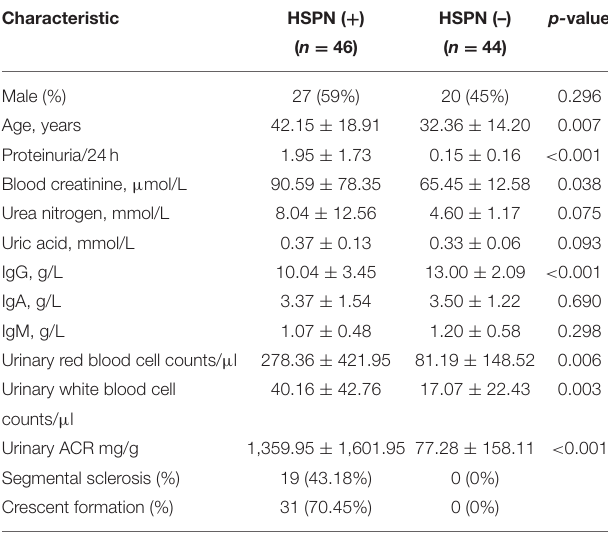
TABLE 1 | Clinical baseline characteristics of the study